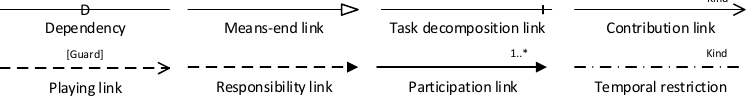
Figure 4. Relationships of the bio-inspired task model.